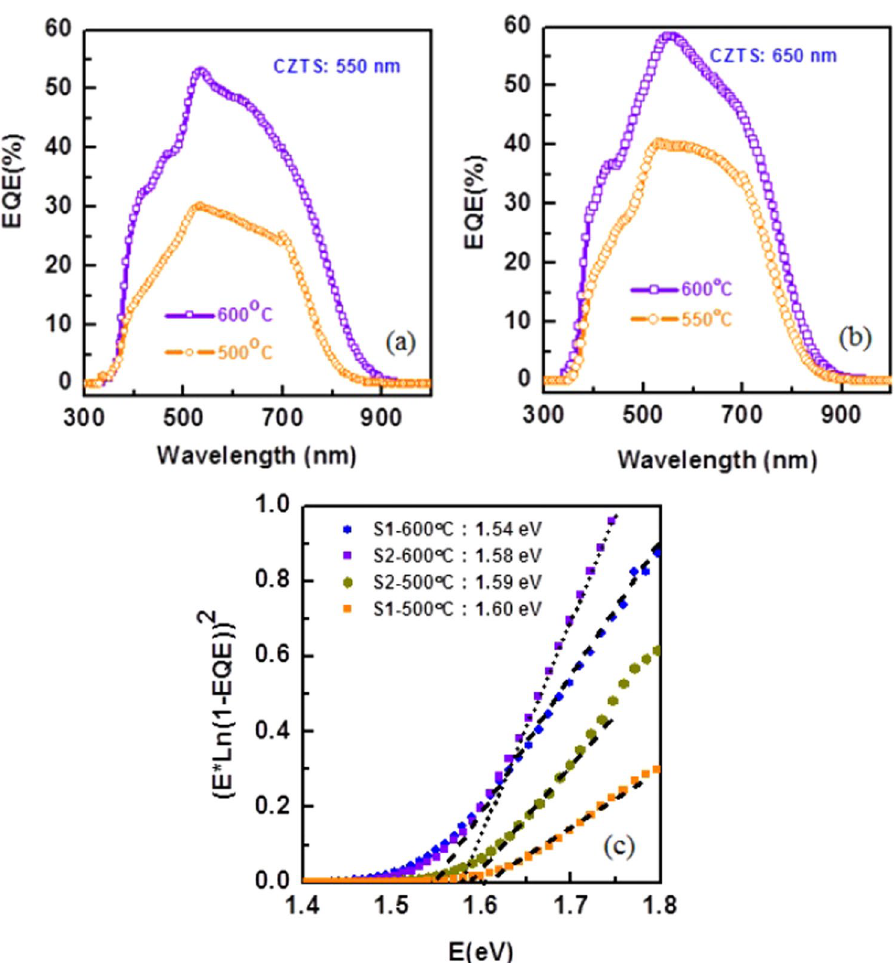
Figure 2. EQE spectra of CZTS solar cells with CZTS thickness of ( a ) 550 nm and ( b ) 650 nm after CZTS layer sulphurized at 500 °C and 600 °C. ( c ) Variation of [E.ln (1-EQE)] 2 versus E to extract bandgap of the CZTS